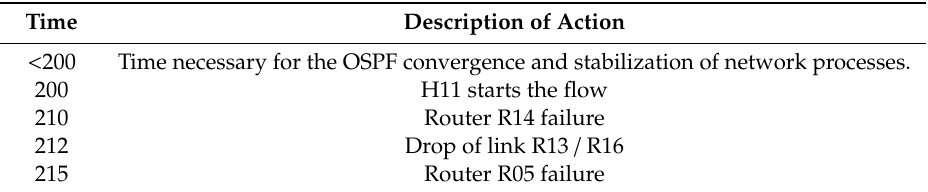
Table 4. Test description.